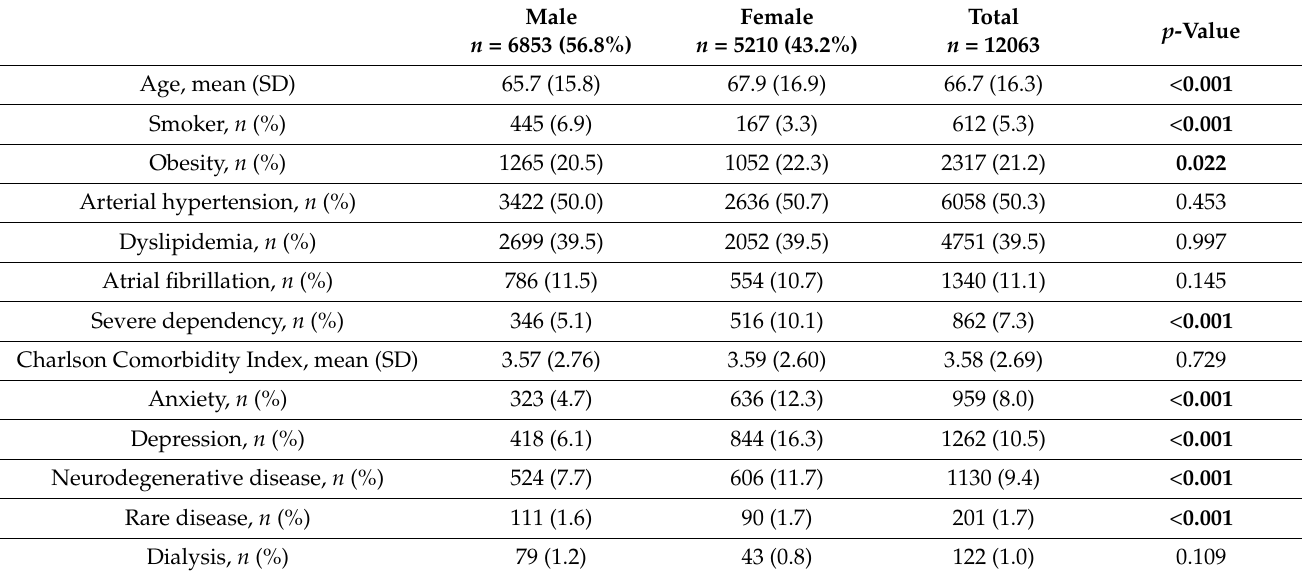
Table 1. Baseline characteristics and comorbidities of the study patients.